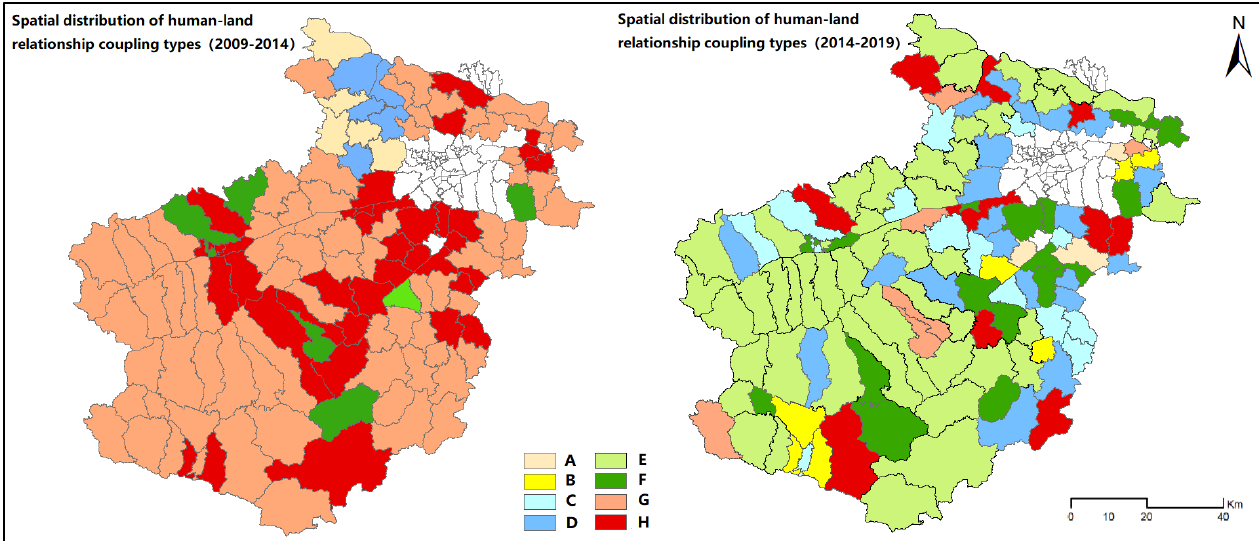
Figure 7. Spatial distribution of human-land relationship coupling types.